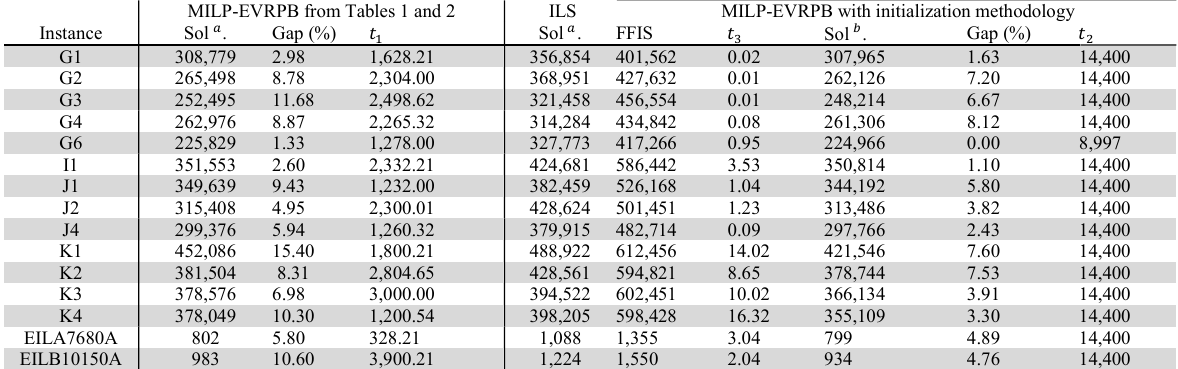
Comparison of the computational results obtained with the proposed mathematical model, the ILS technique and the model with initialization methodology